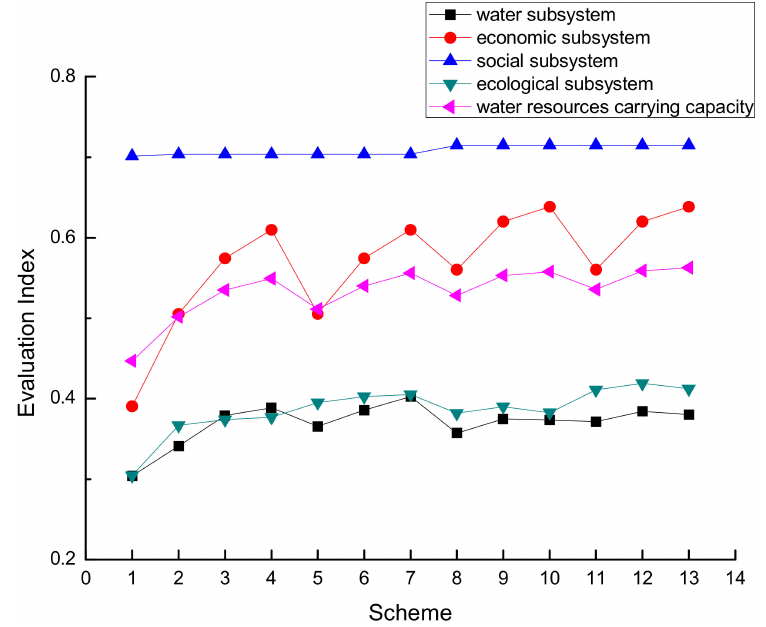
Figure 5. Evaluation indexes of various